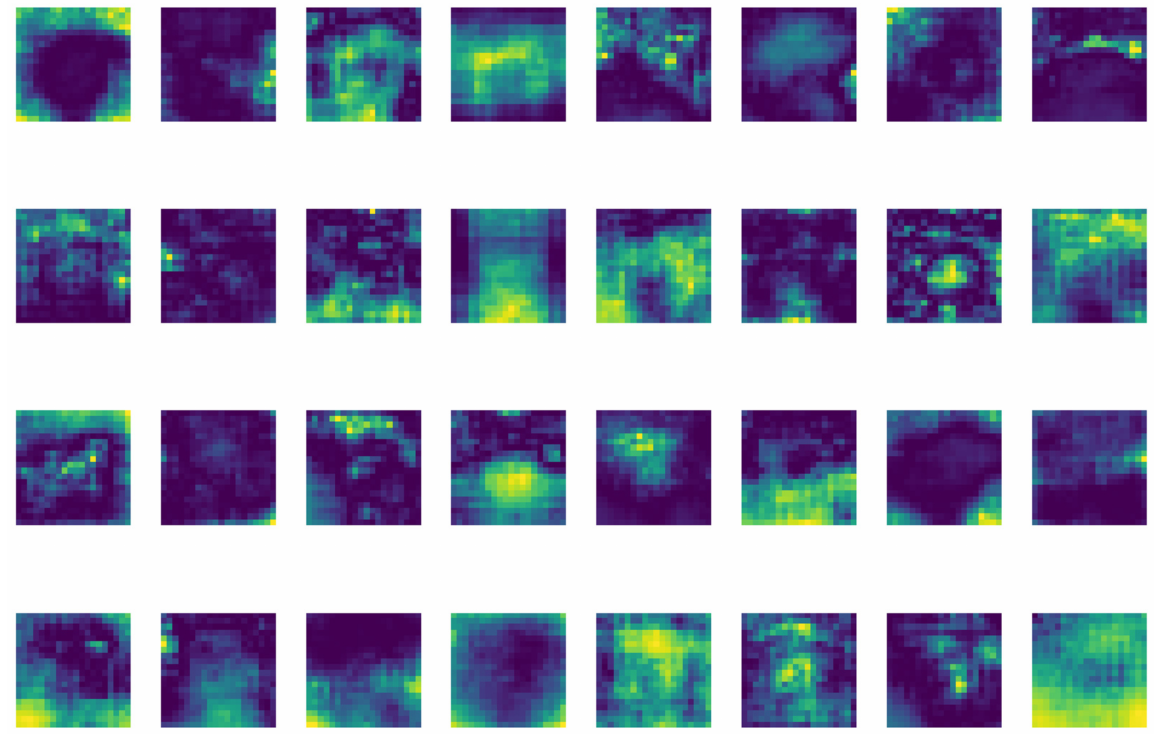
Figure 10. Visualization of the SPP